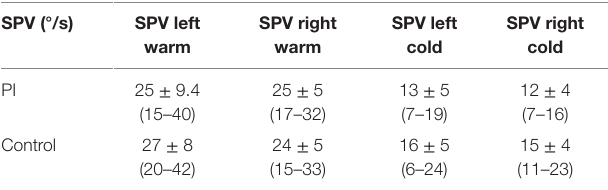
TaBle 1 | Mean slow-phase peak velocity (sPV) of the induced ocular nystagmus obtained for warm and cold irrigations in Pi and control senior